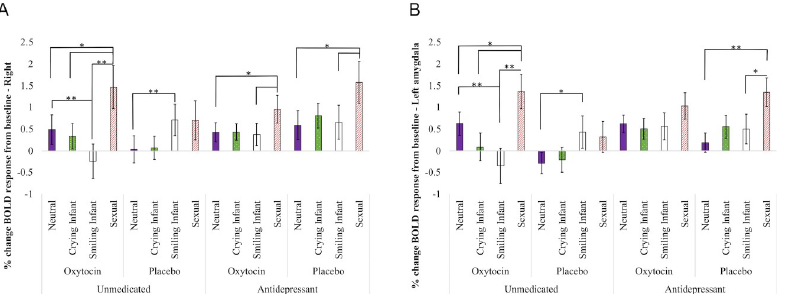
Fig 1. a-b. Activation of amygdala (1a: Left; 1b: Right) to visual emotional stimuli, controlling for age, CES-D score, pre-trial urinary oxytocin, and activation to scrambled images . Contrast bars represent significant differences between response to different stimuli types within the group (i.e., significant repeated measures effects). � : p < 0.05; �� : p <